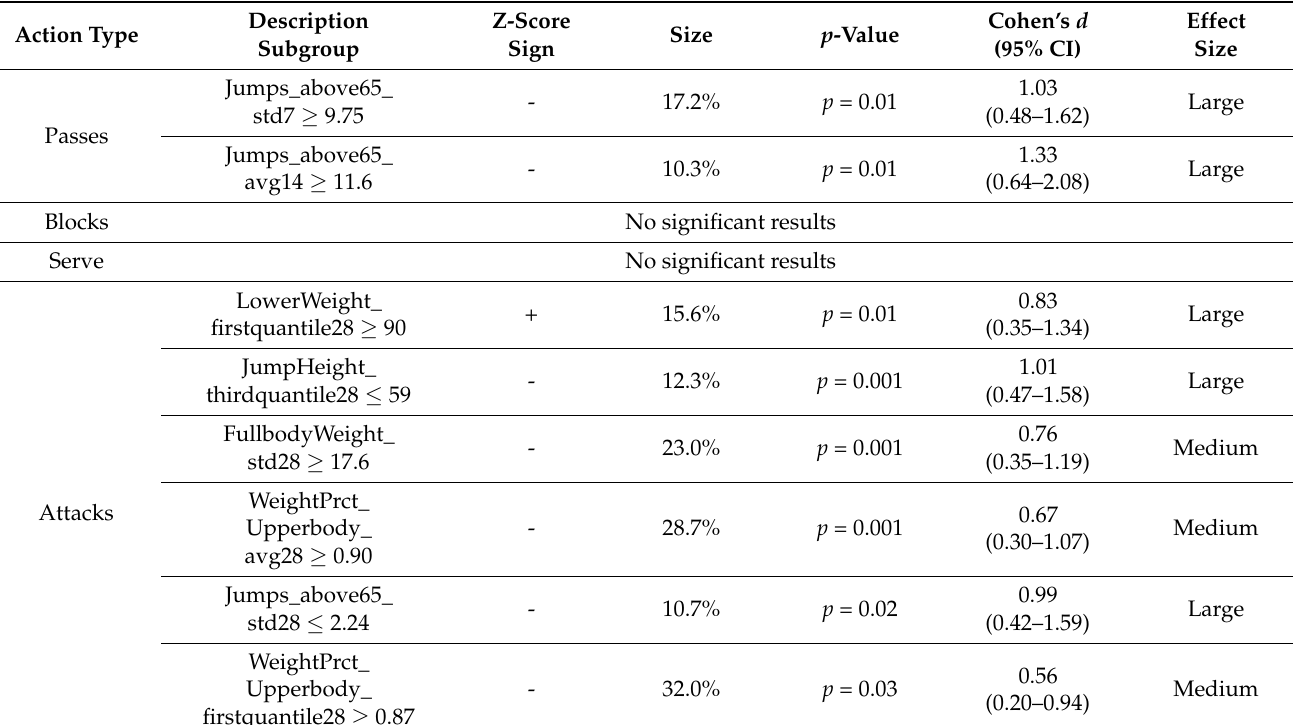
Table 4. Important features per action type revealed by the subgroup discovery analyses. We collected sufficient data to obtain significant results only for passes and attacks. The size of the subgroup is given as a percentage with respect to the size of the entire data collection for the corresponding action type. The description of the subgroups signals a condition on a predictor variable for which the performance scores are significantly different from all performance scores for the action type. A positive (negative) sign of the z-score corresponds to a better (worse) performance, with corresponding effect sizes determined by the absolute value of Cohen’s d